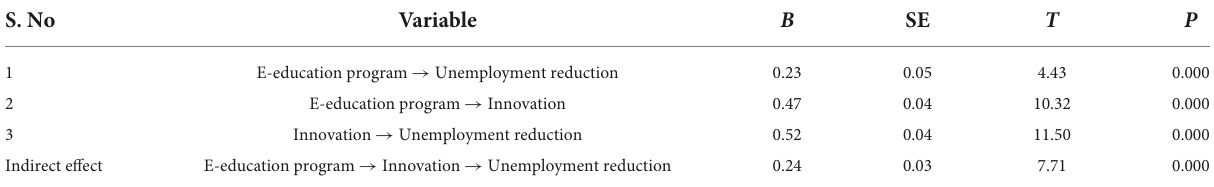
TABLE 3 Structural equation model